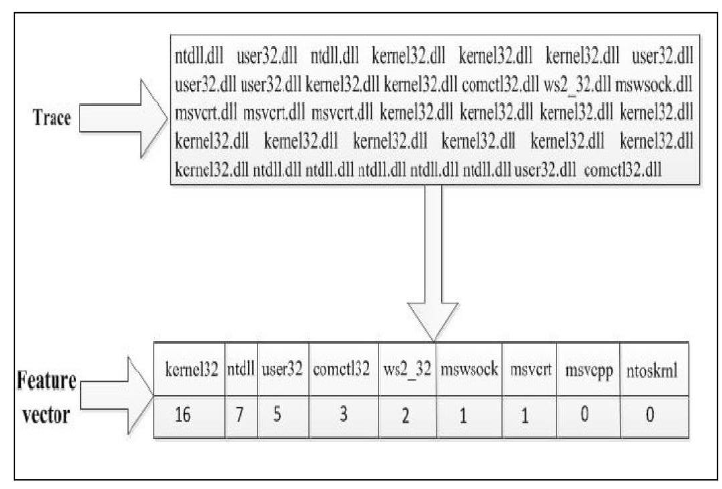
Figure 3. Distinct Dynamic Link Library Count (DDLLC) feature construction